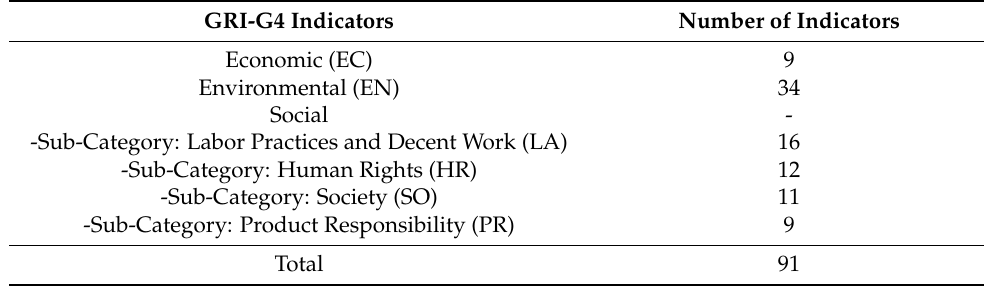
Table 1. GRI-G4 specific standard